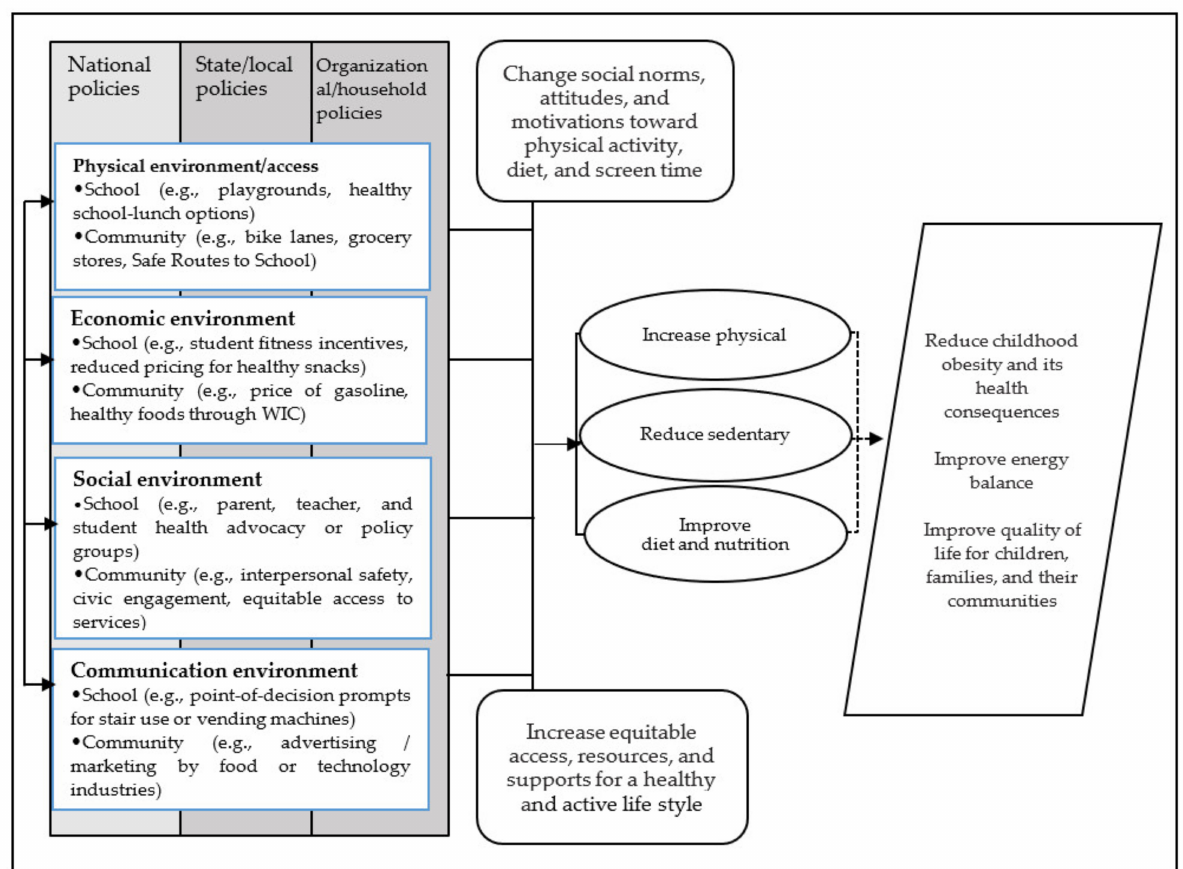
Figure 1. Conceptual framework (adapted from Brennan et al., 2011, with permission) [35]; WIC: Women, Infants, and Children